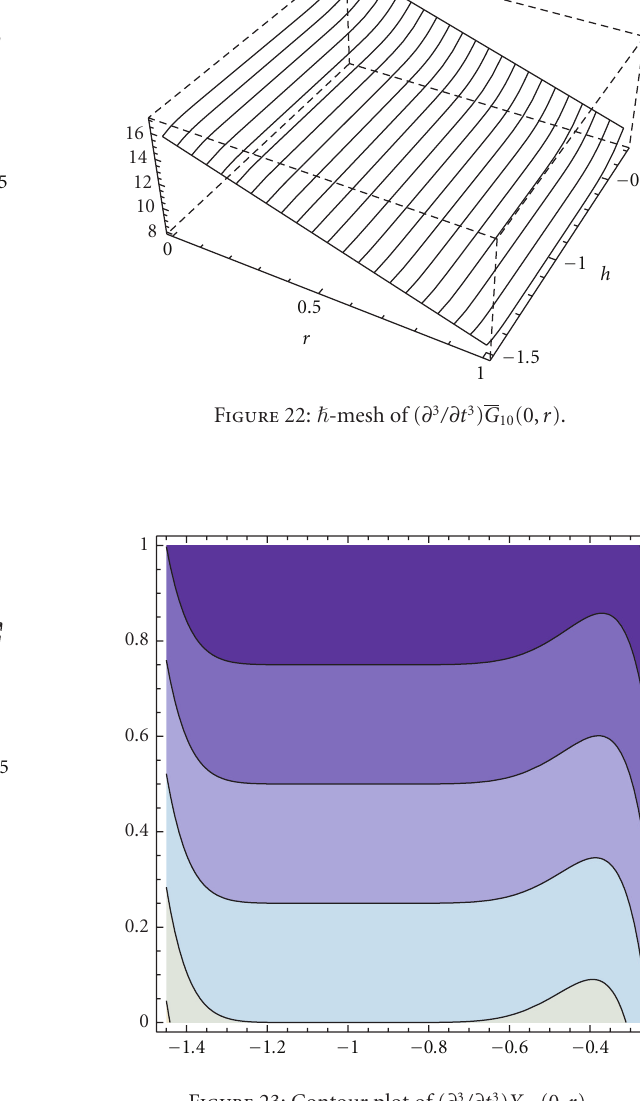
Figure 23: Contour plot of ( ∂ 3 /∂t 3 ) Y